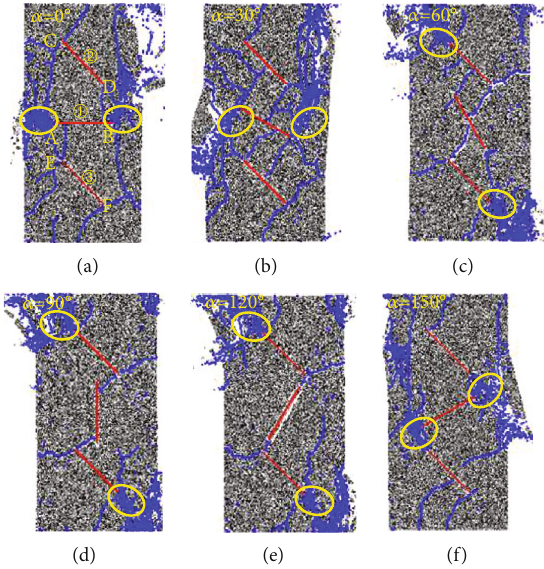
Figure 13: Failure mode of the specimens containing three